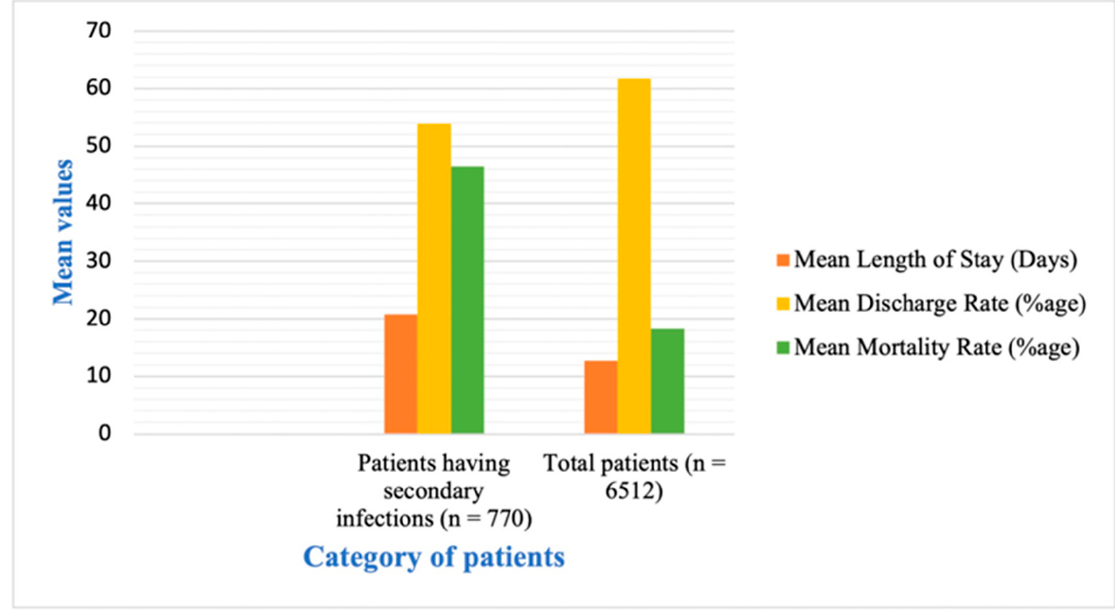
Figure 4. Comparison of hospital stay, discharge rate, and mortality rate in COVID-19 patients with and without secondary infections.